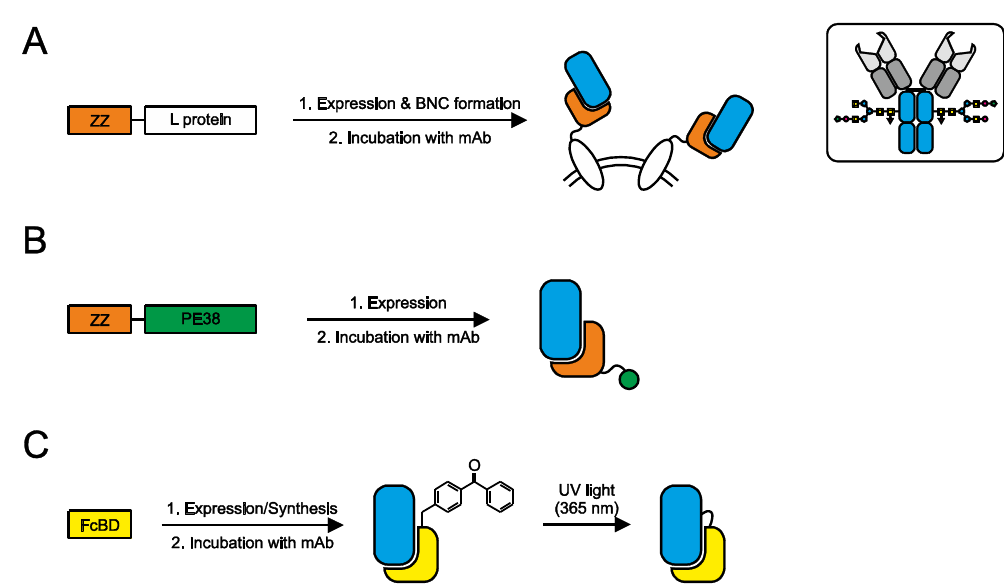
Figure 7. Fc binding domains (FcBD) were exploited as a tool to produce both non-covalent and covalent antibody conjugates. ( A ) The ZZ-domain (ZZ) is expressed as a fusion with the L protein from hepatitis B virus to generate FcBD-bionanocapsules (BNC) that can be decorated with antibodies suitable various in vitro applications. ( B ) When expressed as a fusion protein with Pseudomonas exotoxin A (PE38), the ZZ-domain can be used to generate ADCs. ( C ) If FcBDs are endowed with photoactivable chemical groups, e.g.,